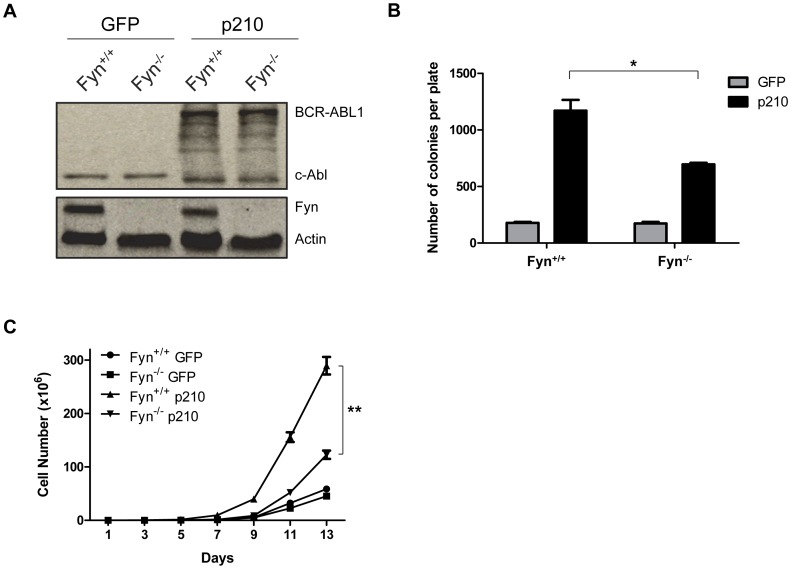
Fyn contributes to the growth and clonogenicity of BCR-ABL1 expressing bone marrow cells.(A) Bone marrow cells from wild-type (Fyn+/+) or Fyn knockout (Fyn−/−) mice were transduced with vector (GFP) or vector expressing p210 BCR-ABL1 (p210). Expression of p210 and Fyn was detected in total protein lysates (100 µg) using antibodies specific for Abl and Fyn, respectively. Actin was used as a loading control. The blot is representative of three independent experiments. (B) Transduced bone marrow cells were plated in methylcellulose soft agar and colonies were counted after five days. *p<0.01, n = 3, mean+SEM. (C) Transduced bone marrow cells were plated in 96-well plates at 150,000 cells/mL. Every two days, cells were stained with trypan blue and viable cells were counted to determine growth rate. *p<0.001, n = 5, mean+SEM.